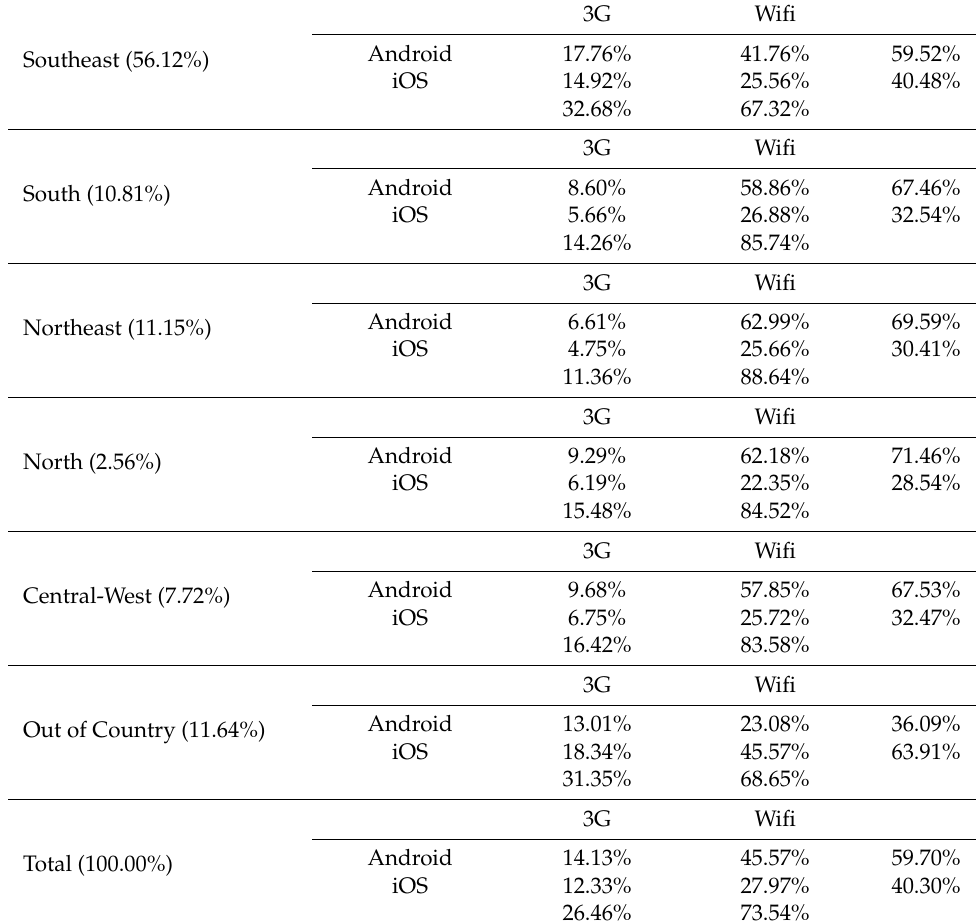
Table 3. Combined percentage of Internet access and operating system by